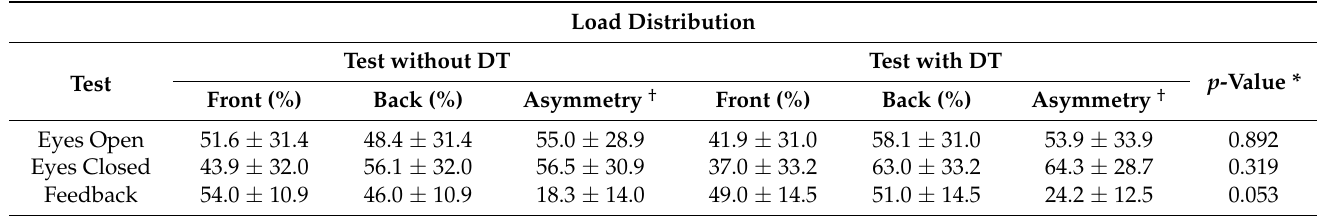
Table 3. Load distributions between the forefoot and heel on a stable